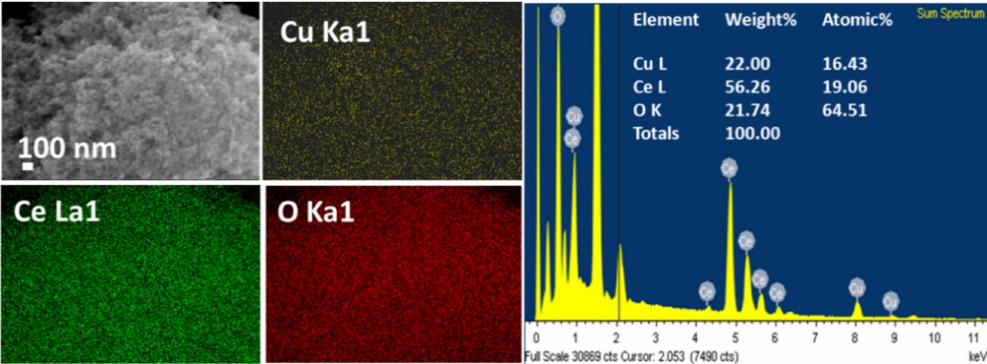
Figure A2. Field emission scanning electron microscopy (FESEM) images, element distributions and energy-dispersive X-ray spectroscopy (EDX) data for the 14% CuCe sample.